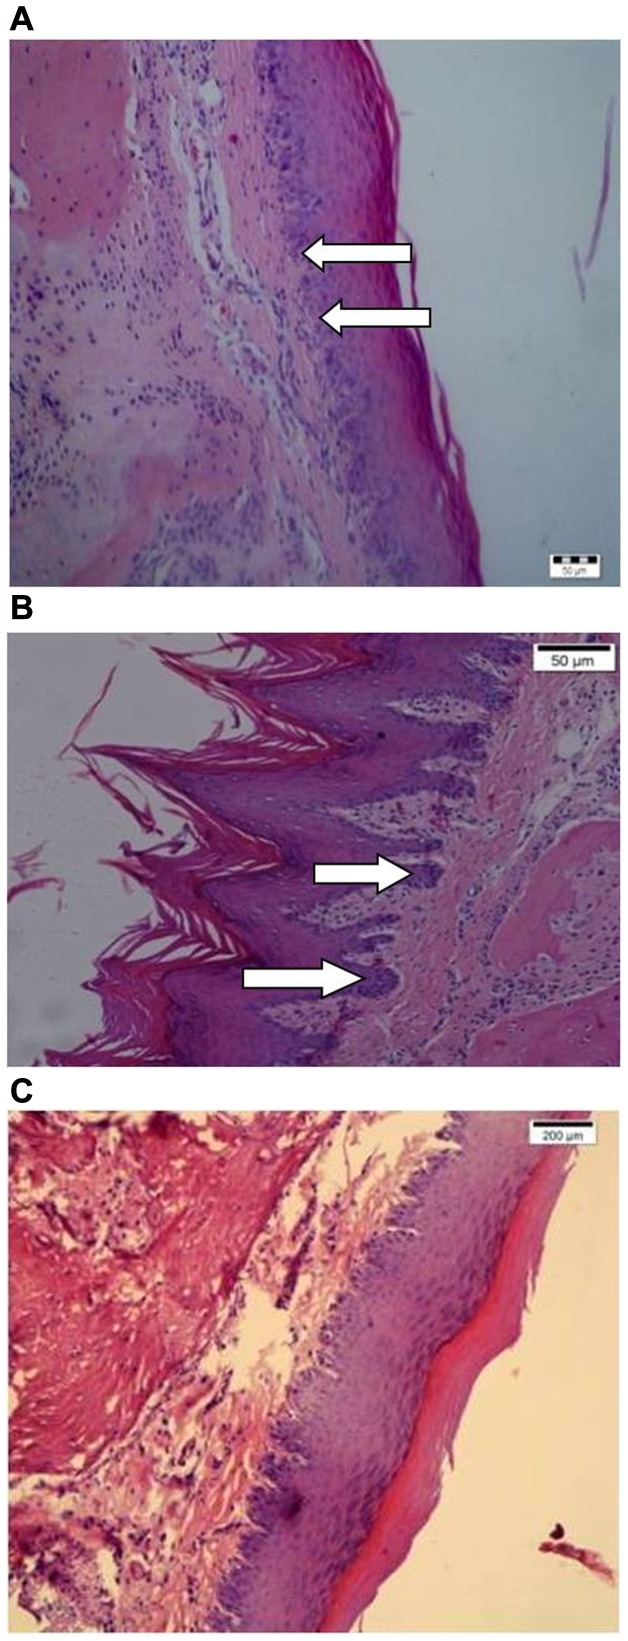
Photomicrograph of paraffin sections of Wistar rat keratinized palatal oral mucosa after hematoxylin eosin staining (200X)(A =  Dentuflex HT, B =  Lucitone 550 HT).In a arrowheads indicate the basal layer interface ridges, and in B the elongated basal layer interface ridges. In C: Control group (without plates).